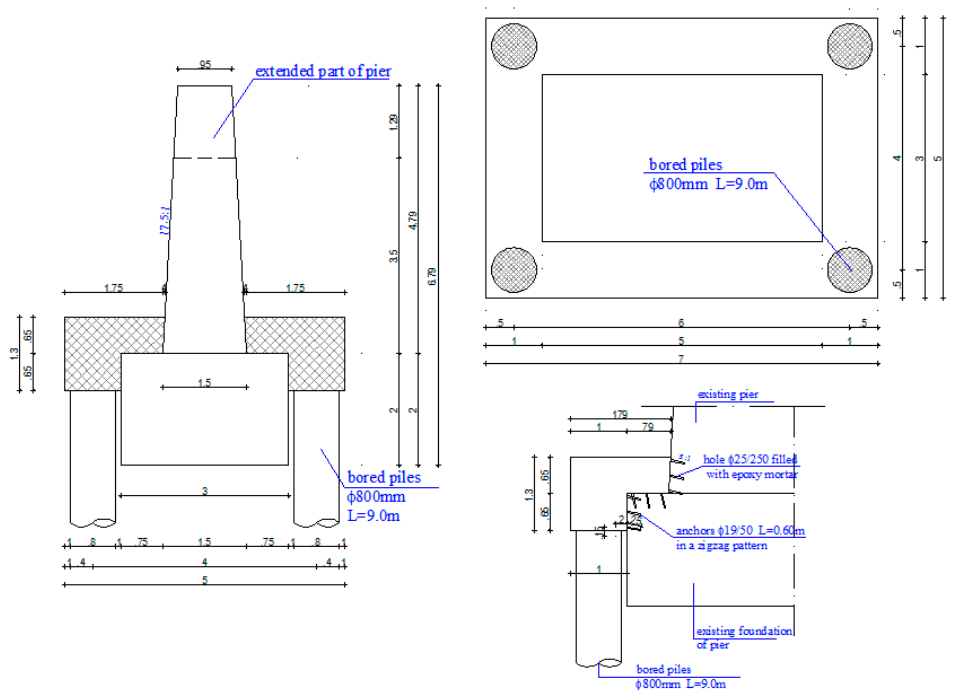
Figure 21. Structural strengthening of the settled river pier